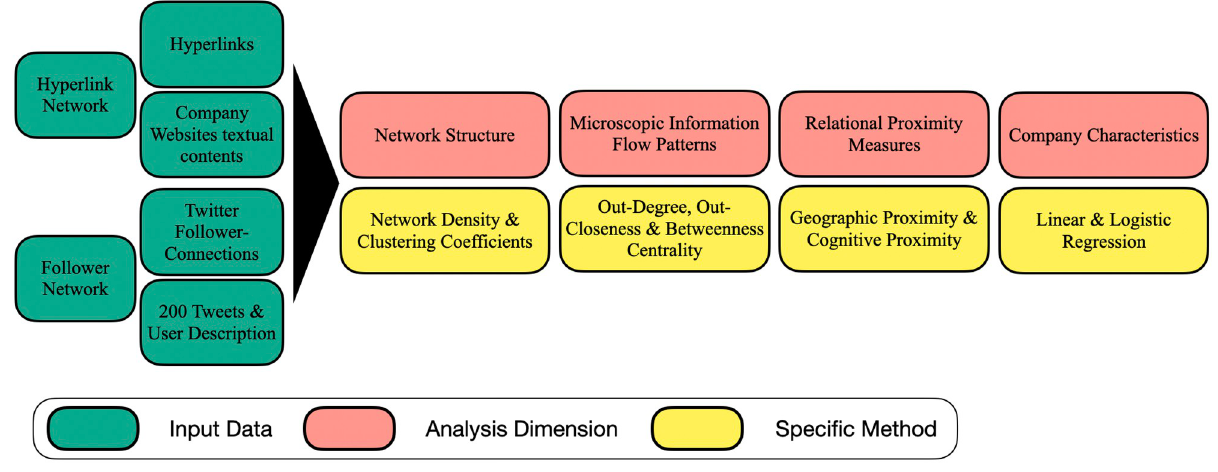
Fig 2. Analysis dimensions and specific